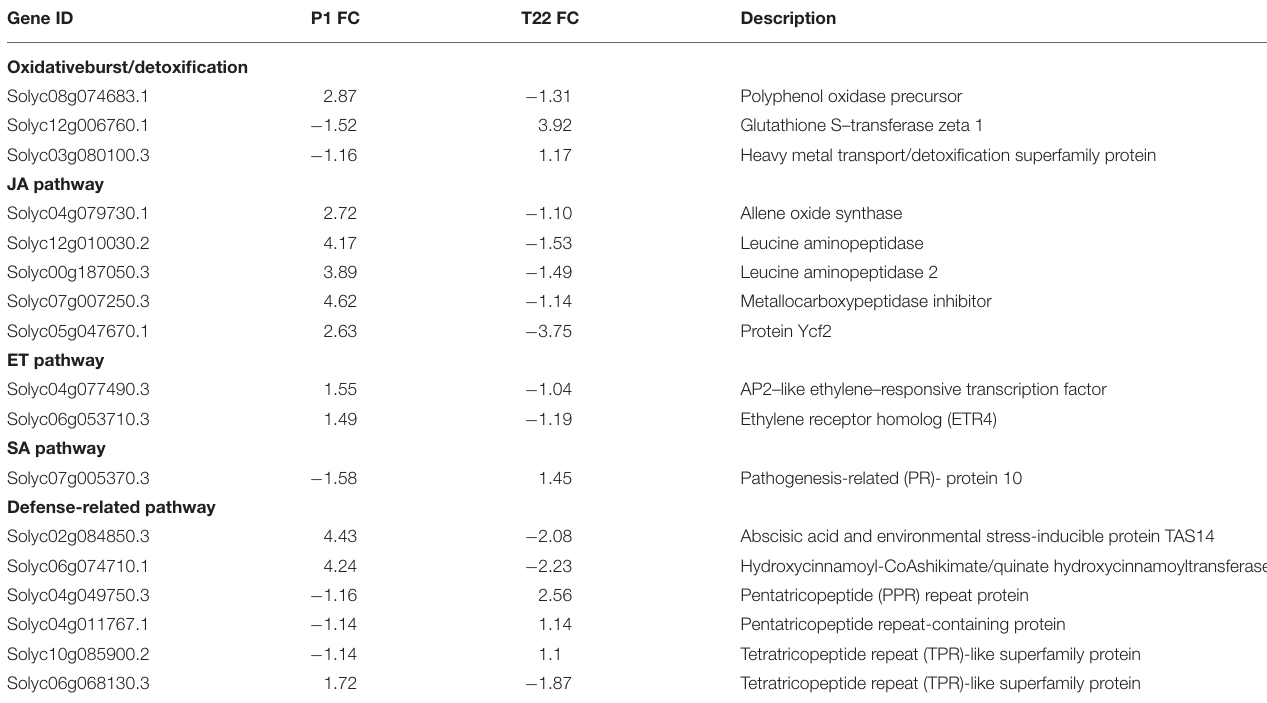
TABLE 3 | Common DEG datasets of tomato treated with Trichoderma strains P1 or T22 and grown at 20 ◦ C, showing opposite regulation